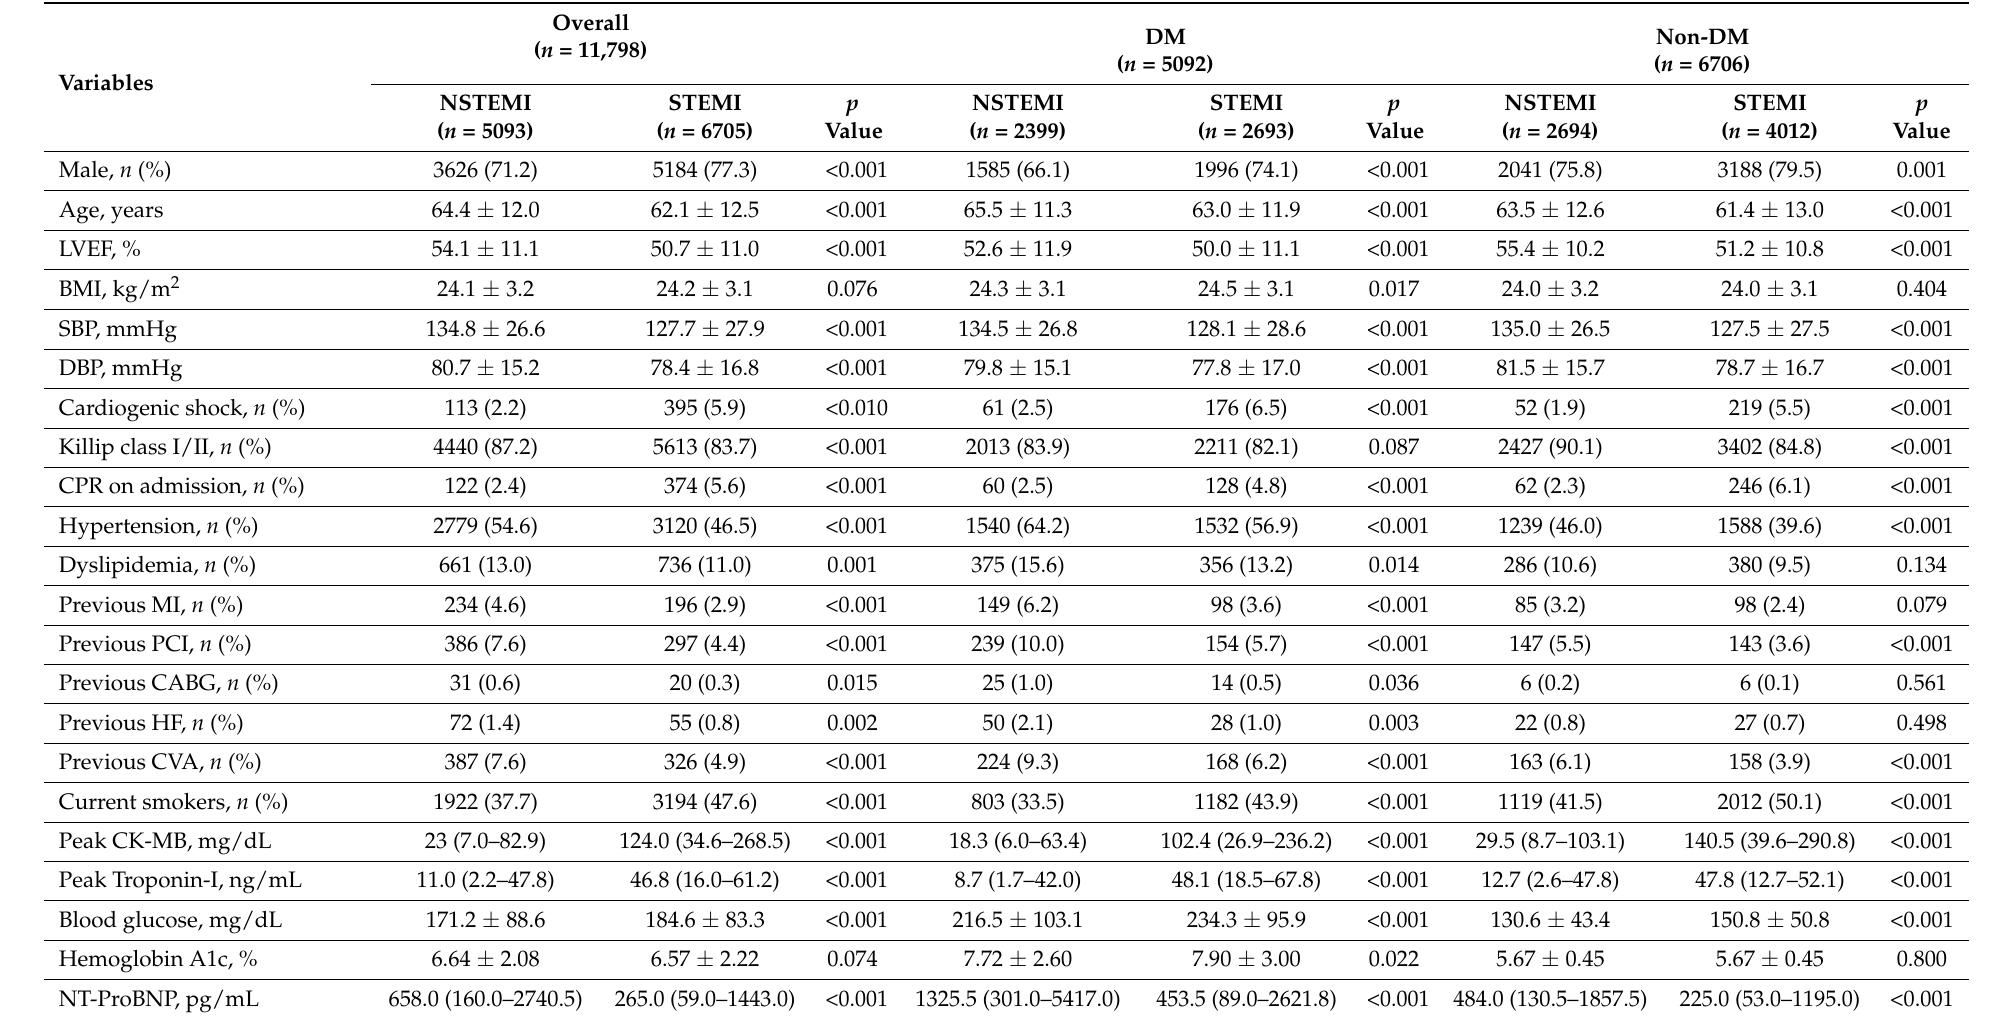
Table 1. Baseline clinical, laboratory, angiographic, and procedural